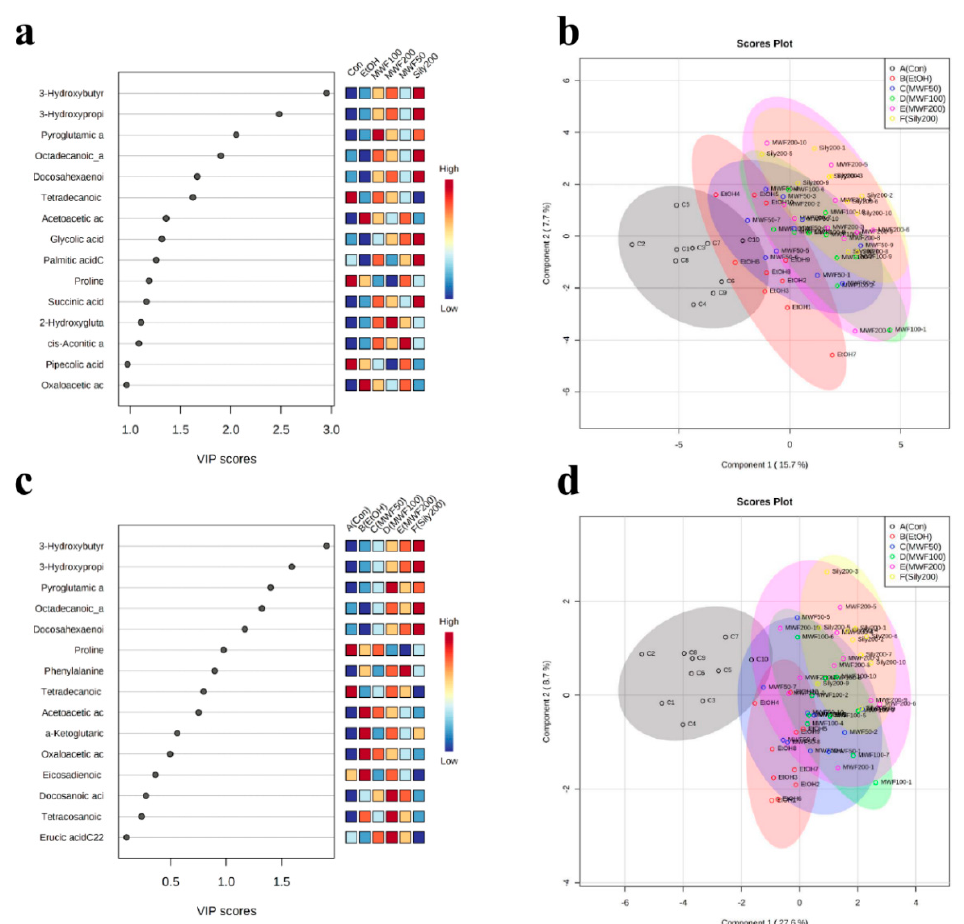
Figure 4. Partial least squares discriminant analysis (PLS-DA) analysis for the Con, EtOH, MWF 50, 100, 200, and Sily200 groups. ( a ) PLS-DA score plot; ( b ) variable importance analysis of top 15 metabolites; ( c ) PLS-DA score plot of significant metabolites in ANOVA; ( d ) variable importance analysis of top 15 metabolites, metabolites that are significant changes in ANOVA. Table 2. The PCA loading score and variable importance point (VIP) score of PLS-DA.